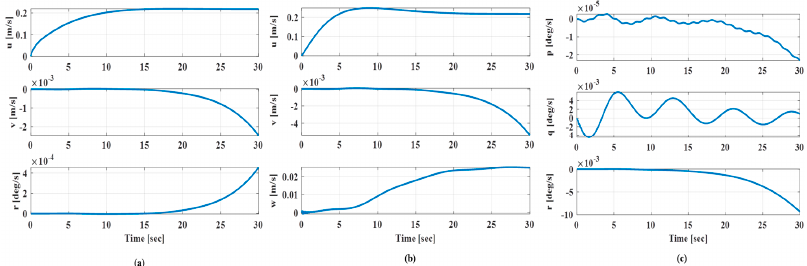
Figure 20. Simulation results of state values of the unmanned ocean platform: ( a ) Linear and angular velocity of the USV; ( b ) Linear velocity of the UUV; ( c ) Angular velocity of the UUV.